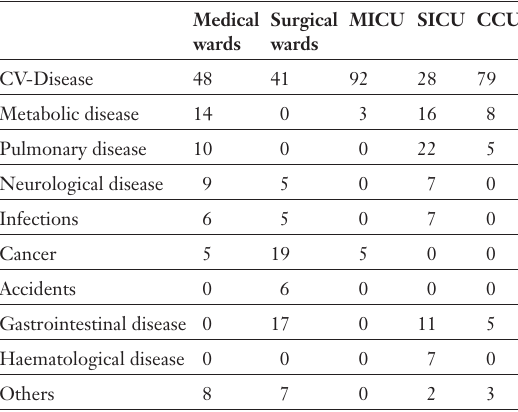
Admission diagnoses of all patients (2002 and 2005) in % of total (one patient may have several